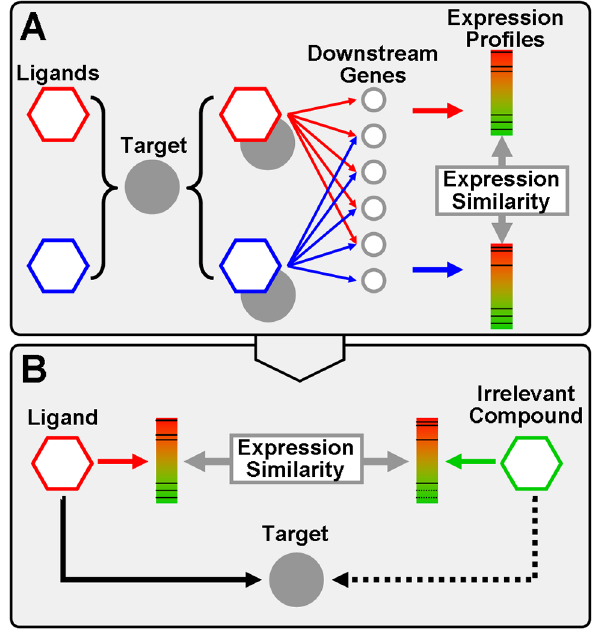
Figure 1. The principle of DTI prediction based on gene- expression information. (A) Ligand-binding modifies the biological functions of protein target, a series of target-related downstream genes are then influenced. Thus, we suppose that variant ligands binding to the same target should influence some downstream genes in common. This hypothesis is corroborated by the fact that drugs sharing common targets result in similar gene-expression profiles in CMap. (B) We therefore applied CMap expression similarity as a guilt-by-association indicator of potential drug-target interactions. If one compound has no recognized interaction with one certain target but shows high expression similarity to the ligands of that target, it may imply undiscovered drug-target interaction.